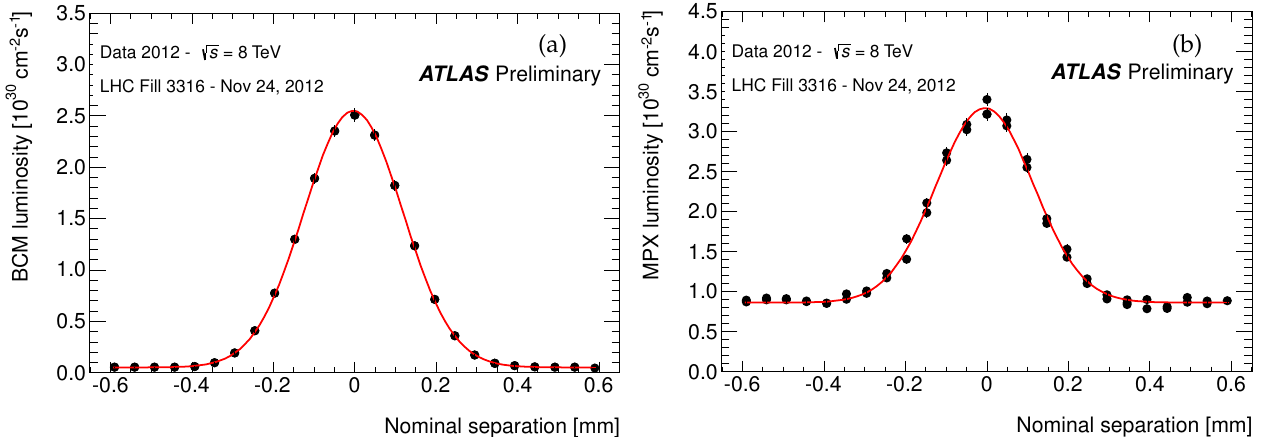
Figure 27. ( a ) BCM luminosity during the last horizontal November 2012 vdM scan summed over all bunches as a function of nominal beam separation. Each data point shows the measured instantaneous luminosity before background subtraction and averaged over the entire duration of a scan step. Data from the scan steps during which the beam separation is varied (non-quiescent beams) are not shown. The fit function is the sum of the proper luminosity that is well represented in this scan by a single Gaussian and of a constant term that accounts for instrumental noise and single-beam background. ( b ) MPX01 hit luminosity (uncorrected) during the last horizontal November 2012 vdM scan summed over all bunches as a function of nominal beam separation. Each data point shows the measured instantaneous luminosity before background subtraction and averaged over one sampling interval of the MPX01 device. The MPX samplings that partially or totally overlap with non-quiescent scan steps (varying beam separation) are not shown. The fit function is the sum of the proper luminosity that is represented in this scan by a single Gaussian and of a constant term that accounts for instrumental noise and single-beam background. Taken from Ref. [12].